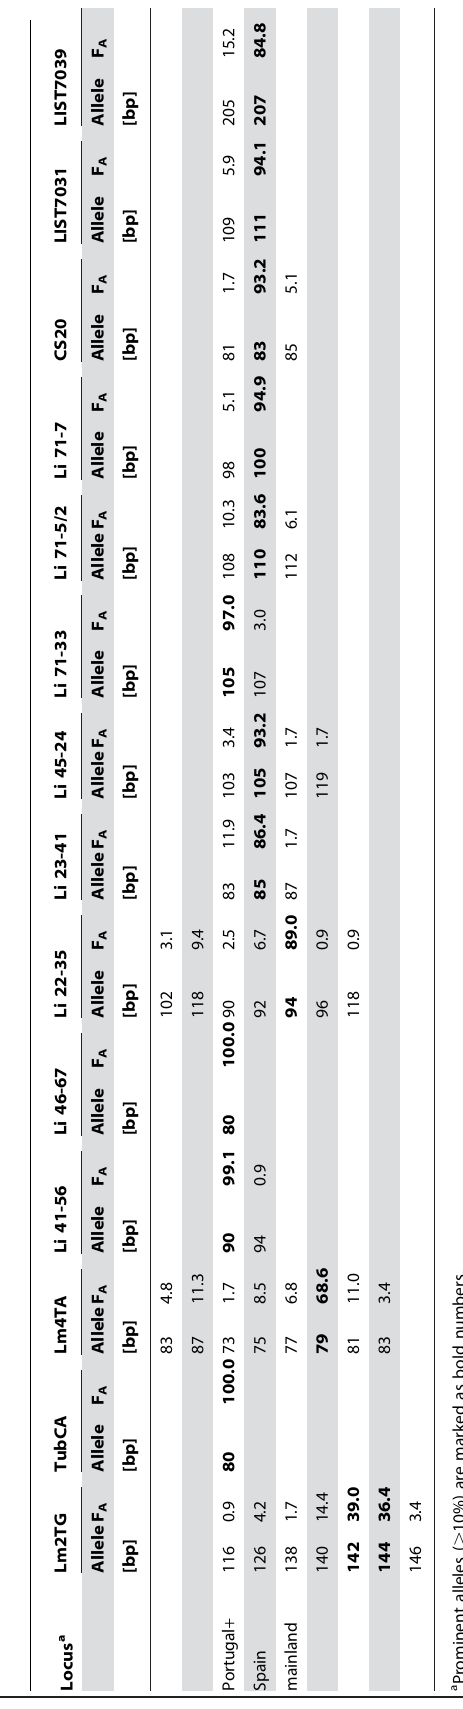
Population 1: Greece (Turkey, Israel, Tunisia). All but one strain from Greece are members of population 1, which falls into two main subclusters: one with most of the Greek strains (Greek cluster) and the other with strains from Tunisia, Israel and Turkey (East Mediterranean cluster). MLMT genotyping did not discriminate between the regions of Athens and Crete, nor between zymodemes MON-98 and MON-1. In fact, six strains originating from Athens and from Crete, and also representing the two zymodemes MON-1 and MON-98 had an identical genotype. Among these identical strains there are human as well as canine isolates. Population 2: Spanish islands-Majorca and Ibiza. This population includes all strains from Ibiza, nine of the twelve strains from Majorca, four of the 17 strains from Madrid, one of the four MON-1 (including MON-108) strains from France (Provence), and unexpectedly three of the ten strains from Alto Douro, Portugal. Eight of the 15 strains from Ibiza form one subcluster in the NJ tree. The three strains from Alto Douro are closely related to each other, and, as well as the strain from France, integrated in the main population 2. There are two genotypes, identical for three strains respectively, and three genotypes shared by two strains each. Population 3: mainland Spain and Portugal. This population includes all but three strains from Portugal, 18 of the 47 strains from Spain, two of the four strains from France and a single strain from Greece (GR17). All four endemic regions from Portugal are represented in this population, without any geographical correlation. Strains from Alto Douro were the most diverse. Unique alleles were found in this region in comparison